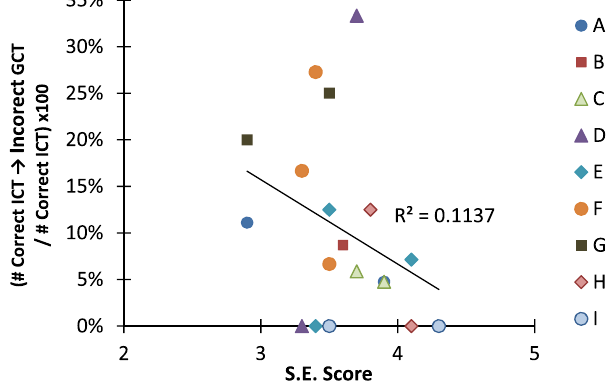
FIG. 9. The number of times each student switched from a correct ICT response to an incorrect GCT response divided by the total number of correct ICT responses for that student (× 100% ) vs each student ’ s self-efficacy score. The average standard error for S.E. score was (cid:2) 0 . 086 , and for percentage of correct ICT switched to incorrect GCT was (cid:2) 2 . 30 %.